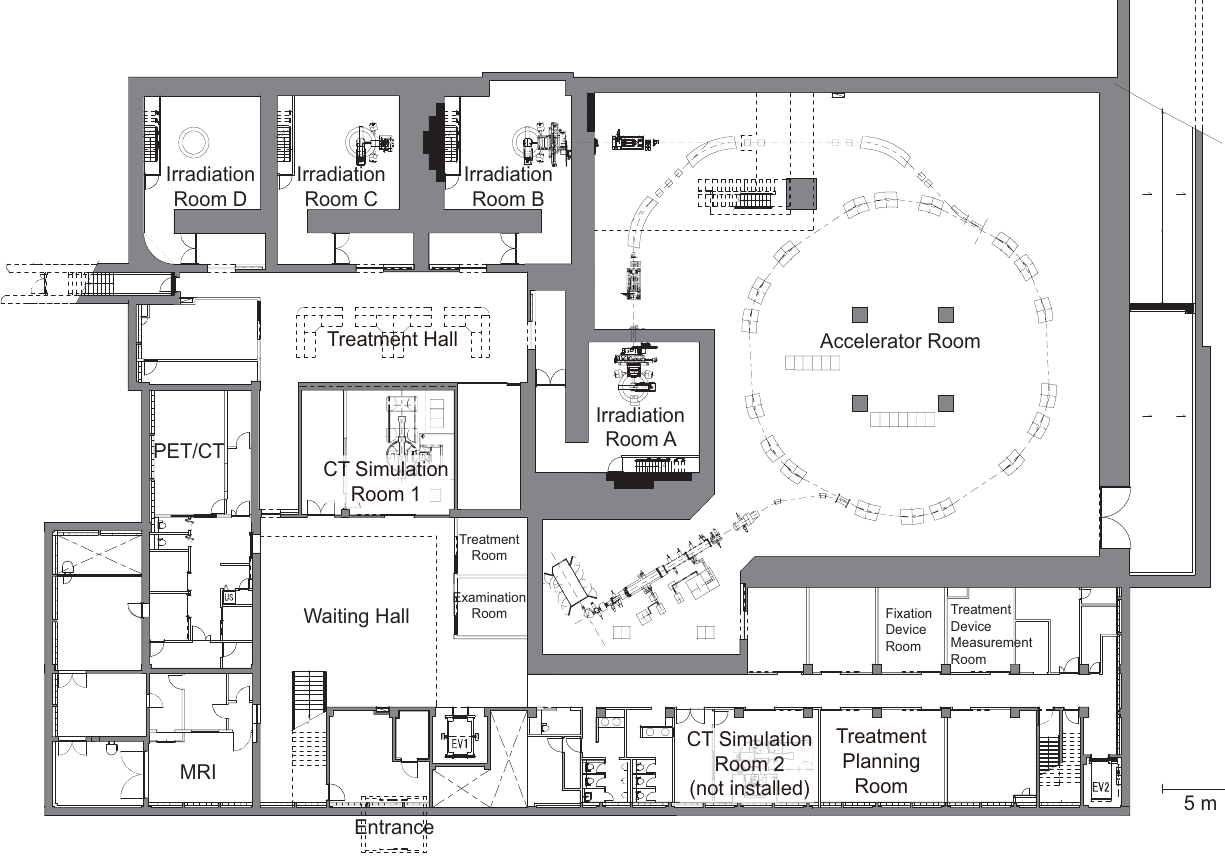
Figure 1. Layout of the B1